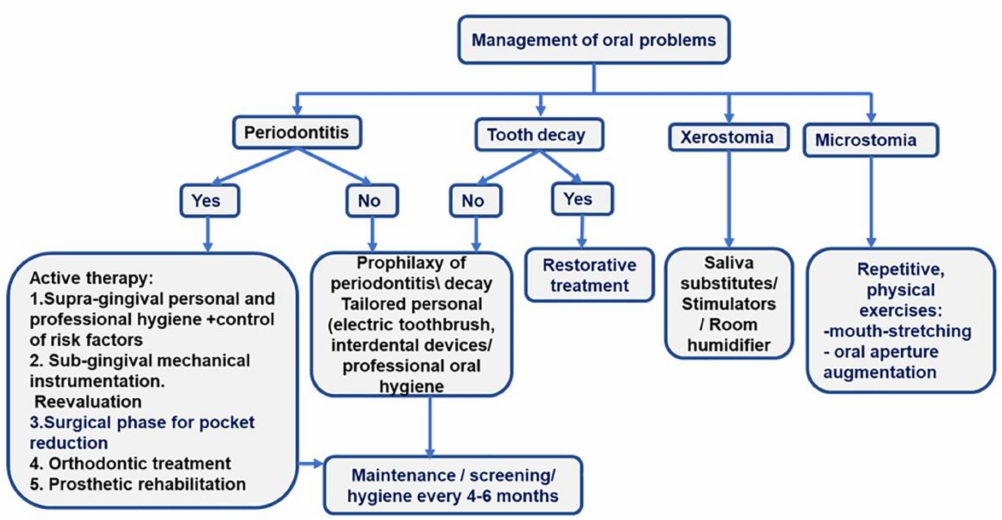
Figure 2. More frequent oral problems in SSc patients and the treatment